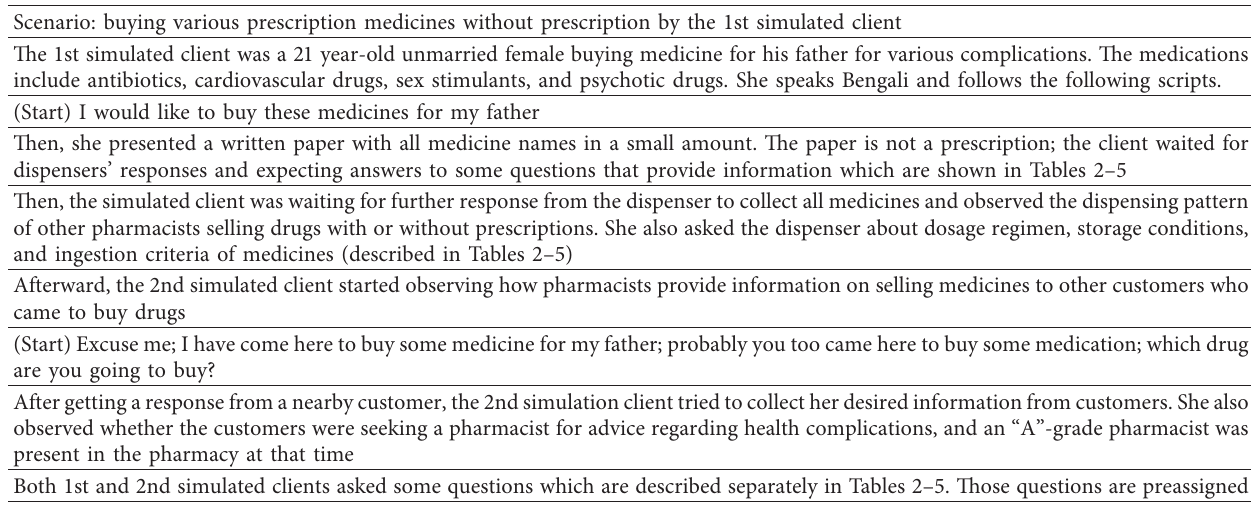
Table 1: Scenarios of medicine dispensing pattern presented by two simulated clients both in retail medicine shops and model pharmacies. Scenario: buying various prescription medicines without prescription by the 1st simulated client